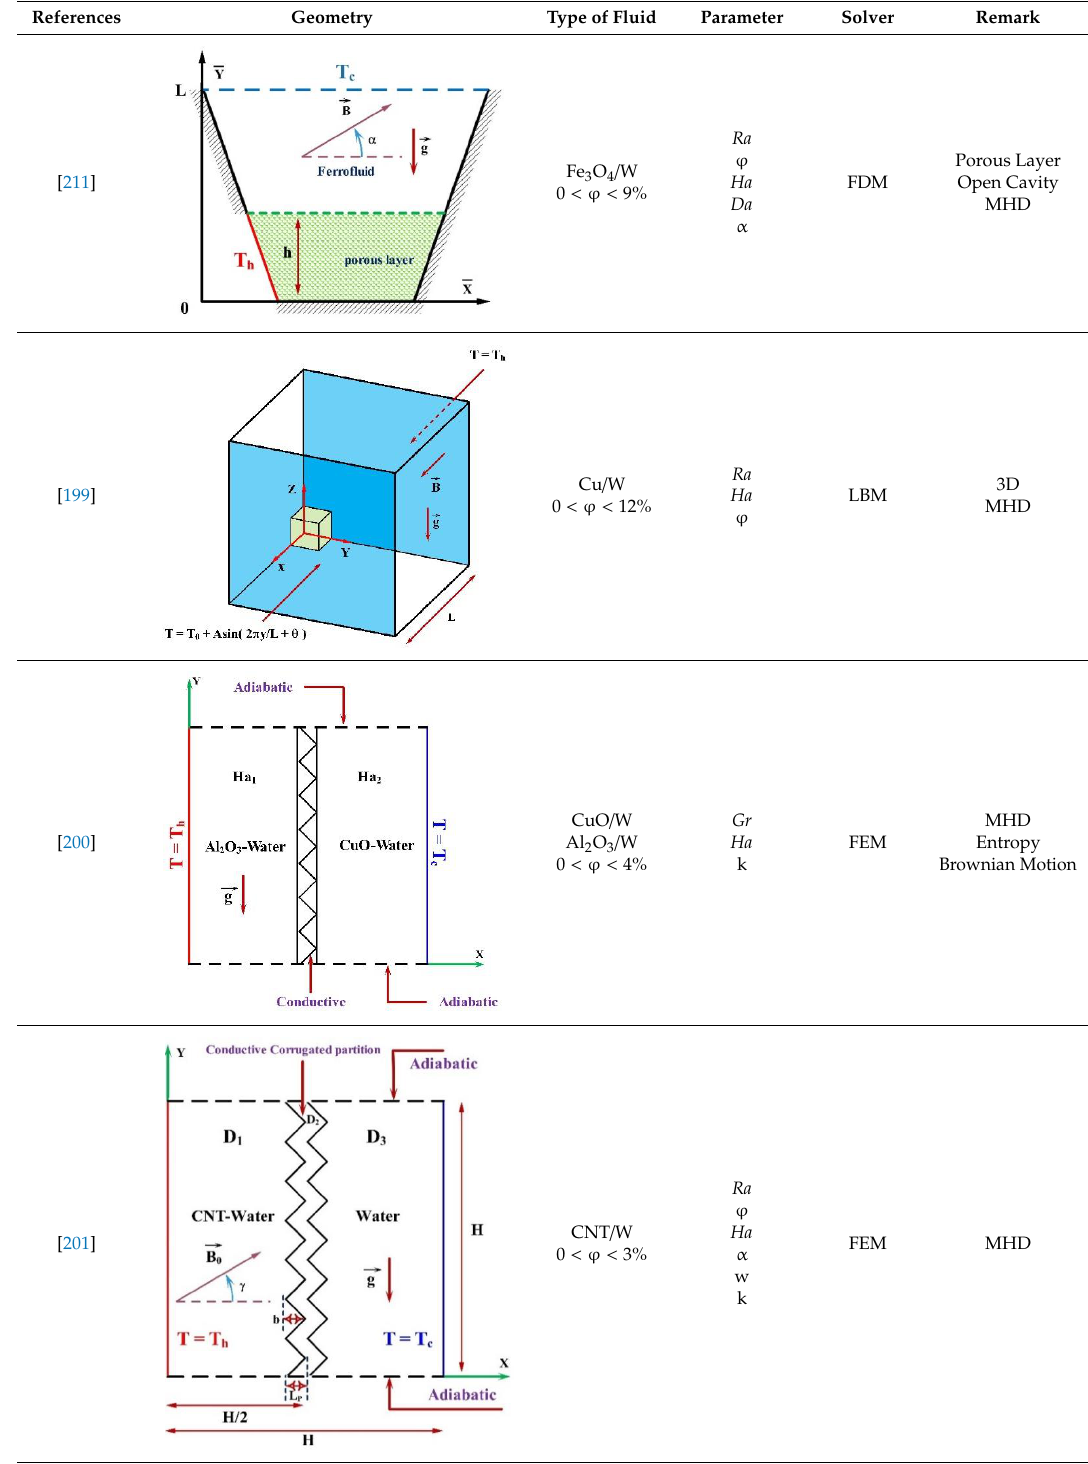
Table 10. Articles studied the enclosures under the influence of the magnetic field.